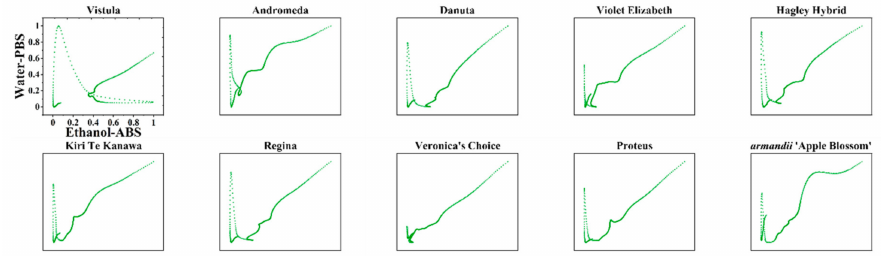
Figure 4. Scatter plots of Vistula, Andromeda, Danuta, Armandii ‘Apple Blossom,’ Proteus, Hagley Hybrid, Violet Elizabeth, Kiri Te Kanawa, Regina, and Veronica’s Choice using data recorded from the 0.1 M PBS after water extraction vs. the 0.1 M ABS after ethanol